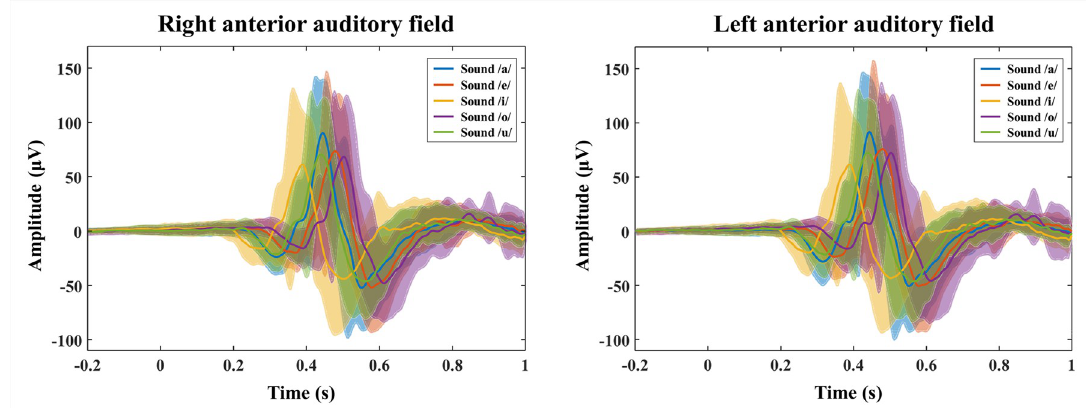
Fig 4. Averaged auditory evoked potentials (AEP) waveforms over the subjects to each vowel sound. AEPs were recorded on the right and left anterior auditory fields (AAFs). Overall, the neural responses were elicited 0.2–0.4 s after the sounds stimulus onset and showed different peak latencies and amplitudes depending on the vowel stimulus. The AEPs recorded on both AAFs were generally similar. The bold lines represent the averaged AEP waveforms, and the shaded areas represent the standard deviation.